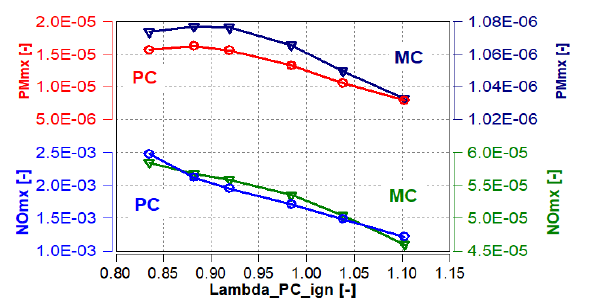
Fig. 19. Changes in NO and soot mass fractions at different air excess ratio at PC_ign Analysis of the thermodynamic and emission